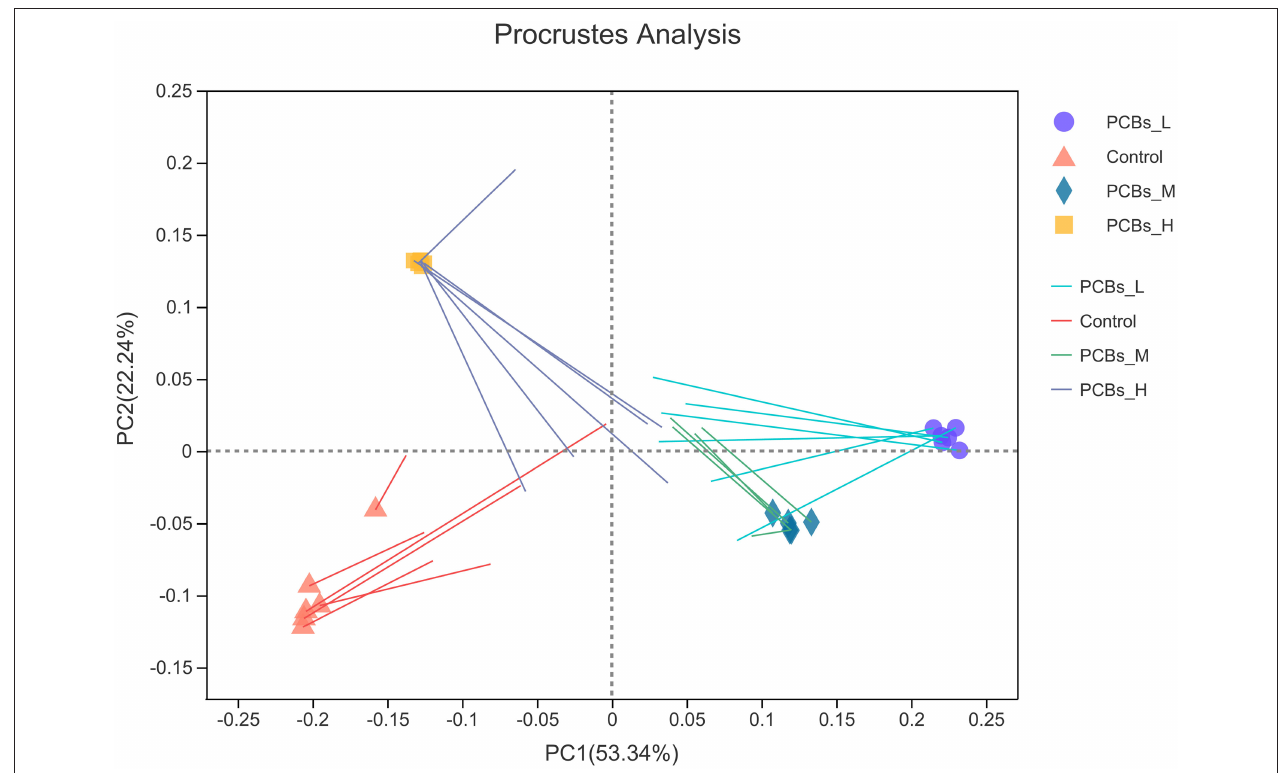
FIGURE 6 | Platts